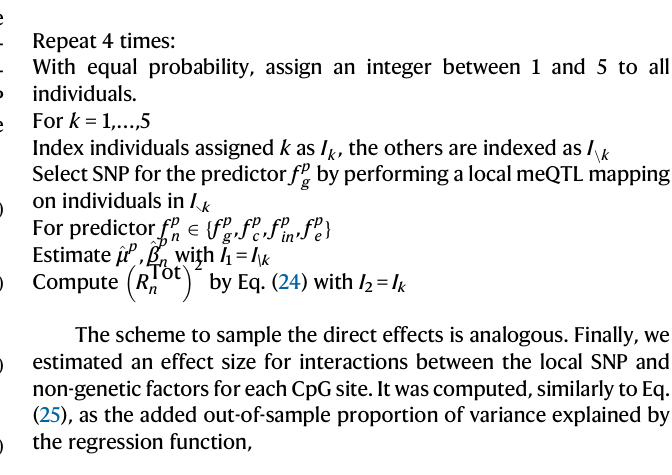
Algorithm2 .Cross-validationforestimatingout-of-samplegrouptotal effect